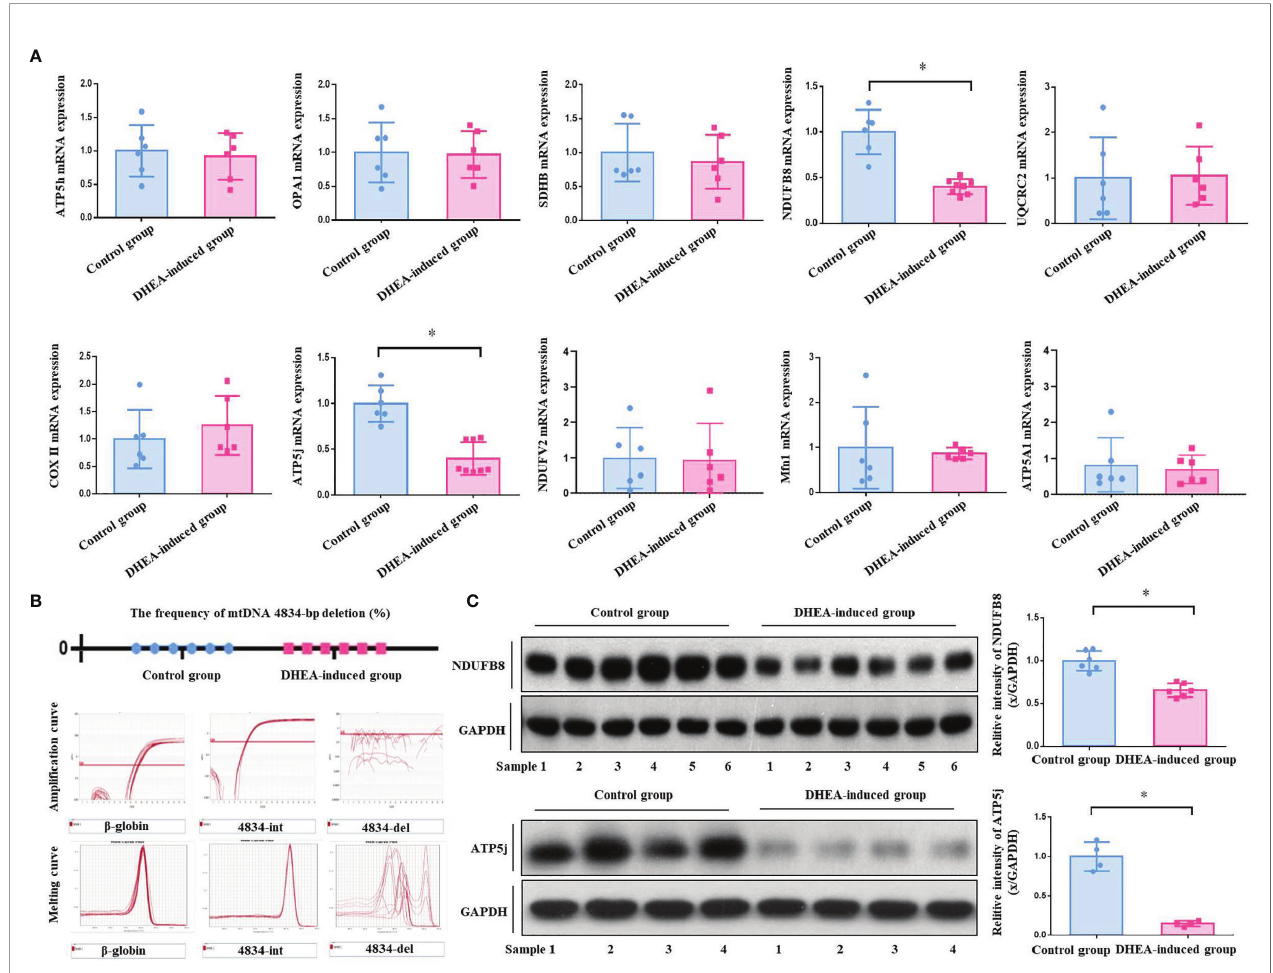
FIGURE 3 | (A) The mRNA expression of mitochondrial functional genes in rat ovarian GCs was detected. A total of 10 mitochondrial functional related genes were analyzed by Real-time PCR. The results showed that the mRNA expressions of gene NDUFB8 (0.40 ± 0.08) and ATP5j (0.40 ± 0.17) in PCOS model rats were signi fi cantly decreased compared with those in control group ones ( NDUFB8 , 1.00 ± 0.22; ATP5j , 1.00 ± 0.18). However, other genes including SDHB, ATP5h, ATP5a1, Opa1, UQCRC2, COXII, NDUFV2 and Mfn1 were not obviously different between two groups. (B) Frequency of mtDNA 4834-bp deleted mitochondria detected. According to Real-time PCR analysis, there was no one with mtDNA 4834-bp deletion in both control and PCOS model group rats. The frequency of mtDNA 4834-bp deletion in both two groups was 0.00%. According to the ampli fi cation curve and melting curve, the int primer pair had speci fi c ampli fi cation in the PCOS model group, while the del primer pair had no speci fi c ampli fi cation, veri fi ed the results from both positive and negative perspectives. (C) The protein expressions of mitochondrial functional genes NDUFB8 and ATP5j were detected. According to Western Blot analysis, the protein expression of mitochondrial functional genes NDUFB8 and ATP5j in the ovarian GCs of the PCOS model group rats were obviously decreased compared with those in the control group. The results were consistent with those of Real-time PCR analysis. * P < 0.05.